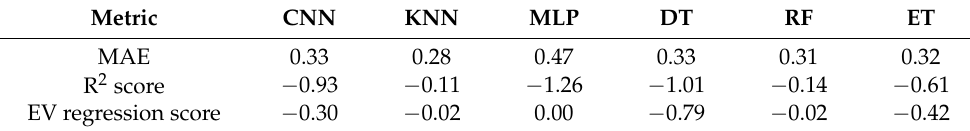
Table 10. Evaluation metrics for test set of the whole information dataset.